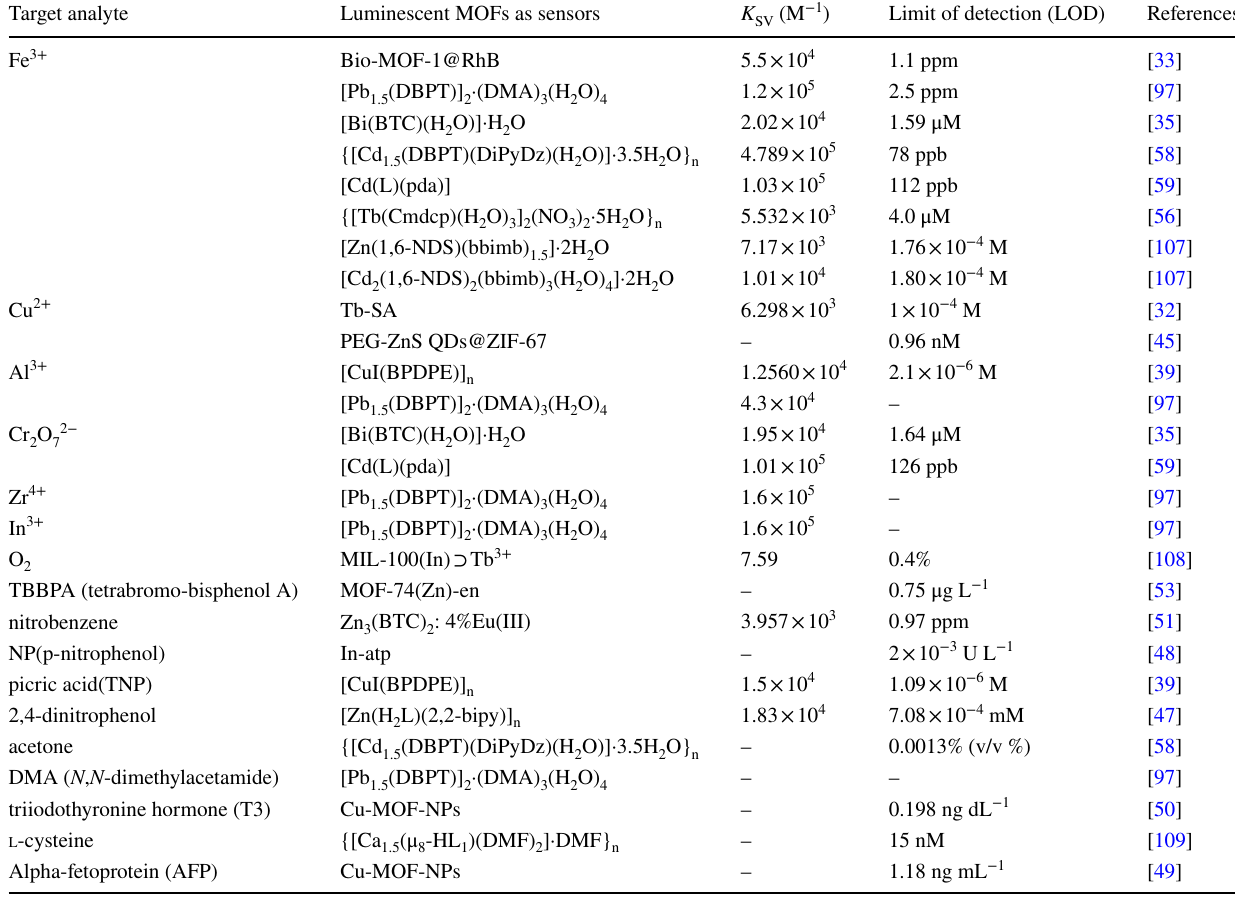
Table 3 Photoluminescent sensors based on MOFs toward various analytes Target analyte